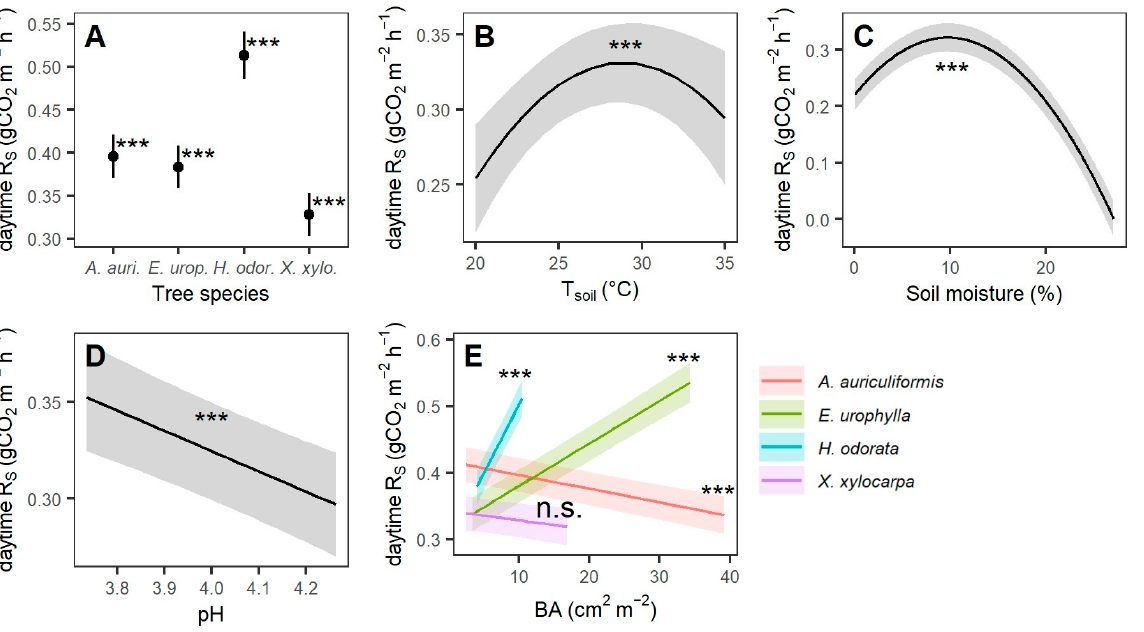
Figure 5. Estimated relationship between hourly rates of soil respiration (R S ) during daytime and the marginal effects of the mixed-effects model, specifically tree species ( A ), soil climatic conditions ( B , C ), soil pH ( D ), and local basal area ( E ). The solid line represents the fitted curve, while the shaded area represents the 95% confidence interval. Significance stars represent p -value (*** p < 0.001; n.s. p > 0.05). See Table A2 for a tabular description of the model estimates.